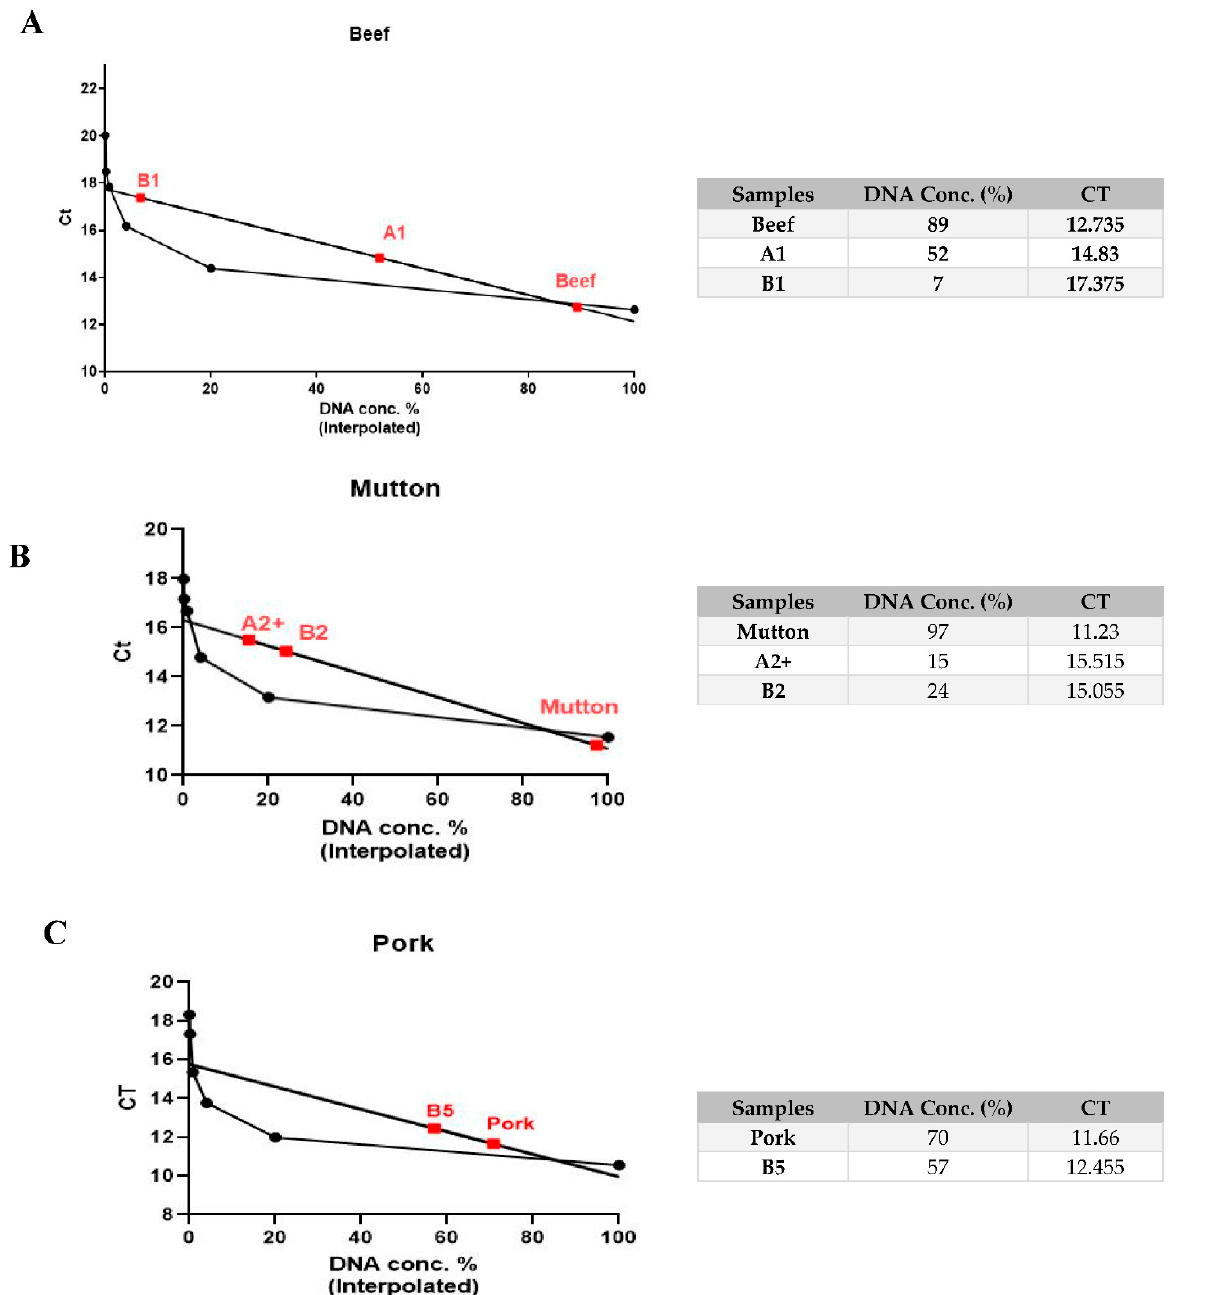
12 of 16 Figure 3. Amplification of serial concentrations of meat DNAs obtained from different species: ( A ) cattle, ( C )B sheep,